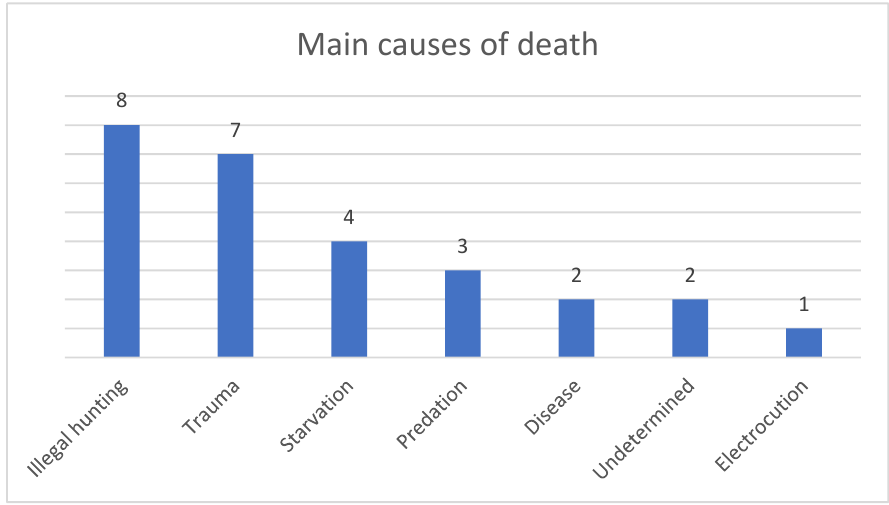
Figure 1. Main causes of death in reintroduced Northern Bald Ibis analyzed at CeMedForVet in the period 2016 – 2022. Table 1. Causes of death and key information related to reintroduced Northern Bald Ibis analyzed at CeMedForVet in the period 2016 – 2022.